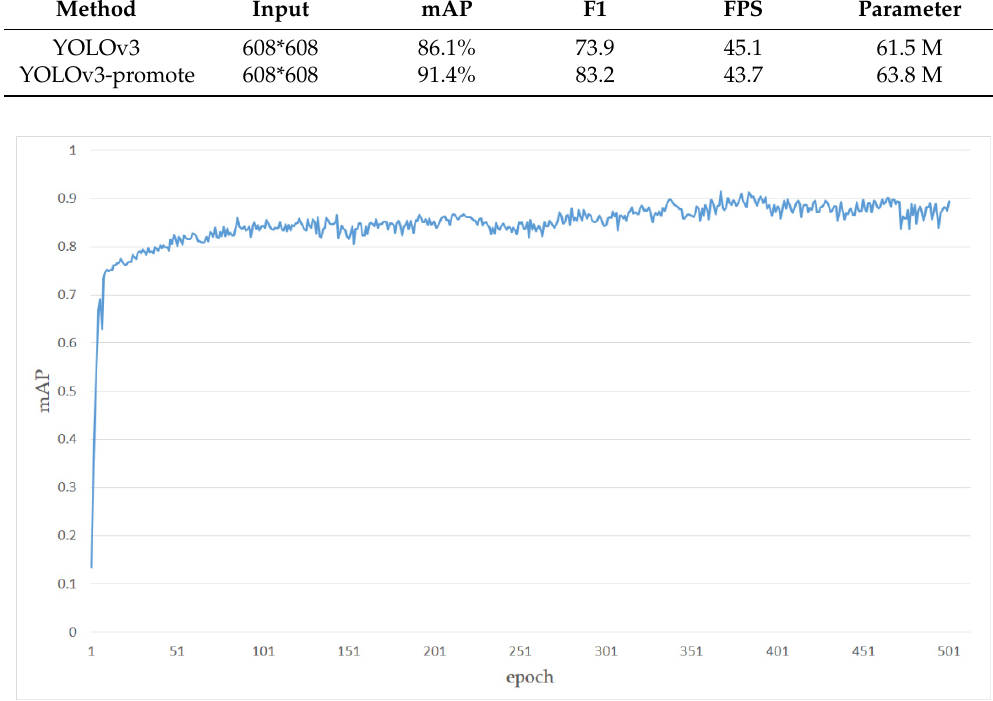
Figure 10. Mean average precision (mAP). Table 1. Performance comparison of algorithms.